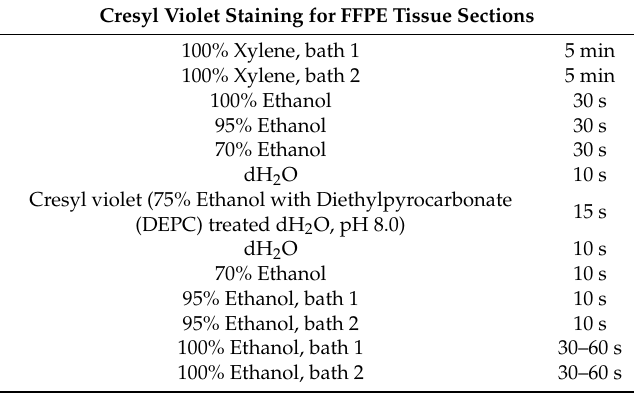
Table 3. Staining protocol for Cresyl violet staining of formalin-fixed paraffin embedded (FFPE) tissue